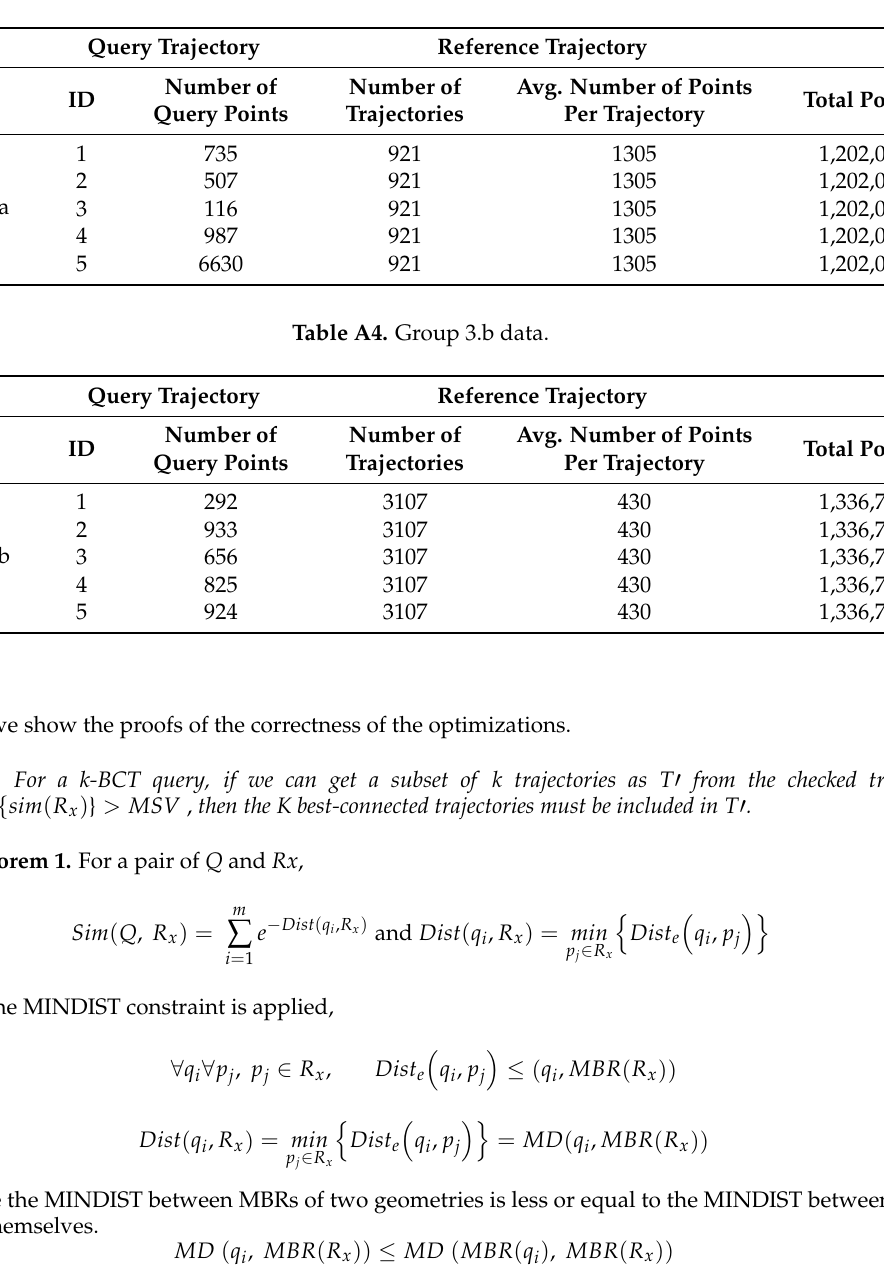
Table A3. Group 3.a data.